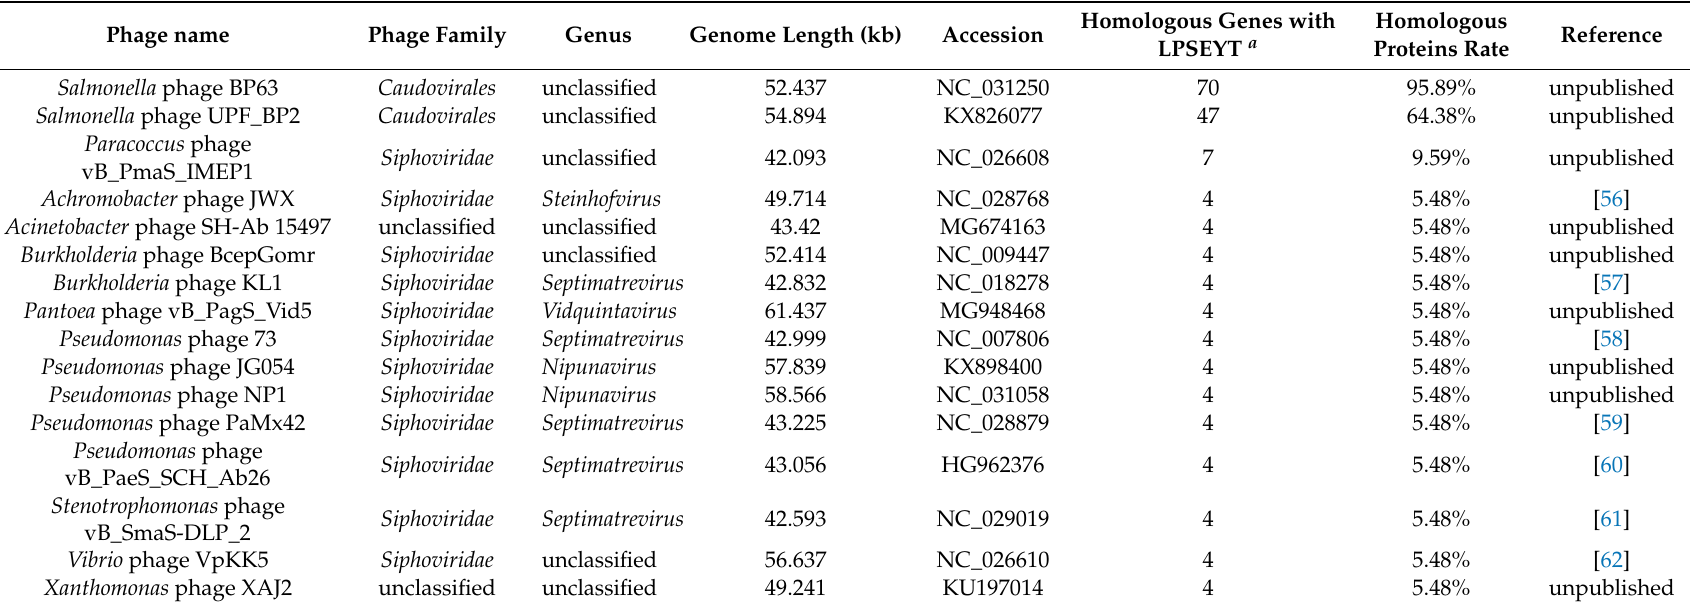
Table 3. Phages with homology genes with Salmonella phage LPSEYT by